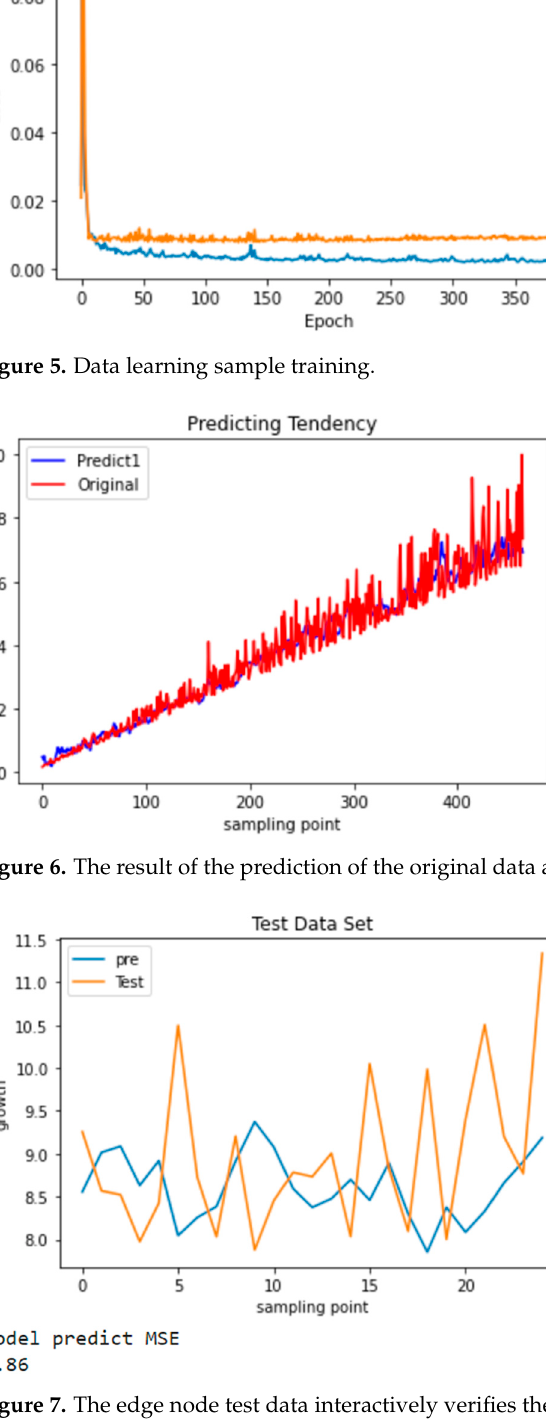
Figure 7. The edge node test data interactively verifies the training results.